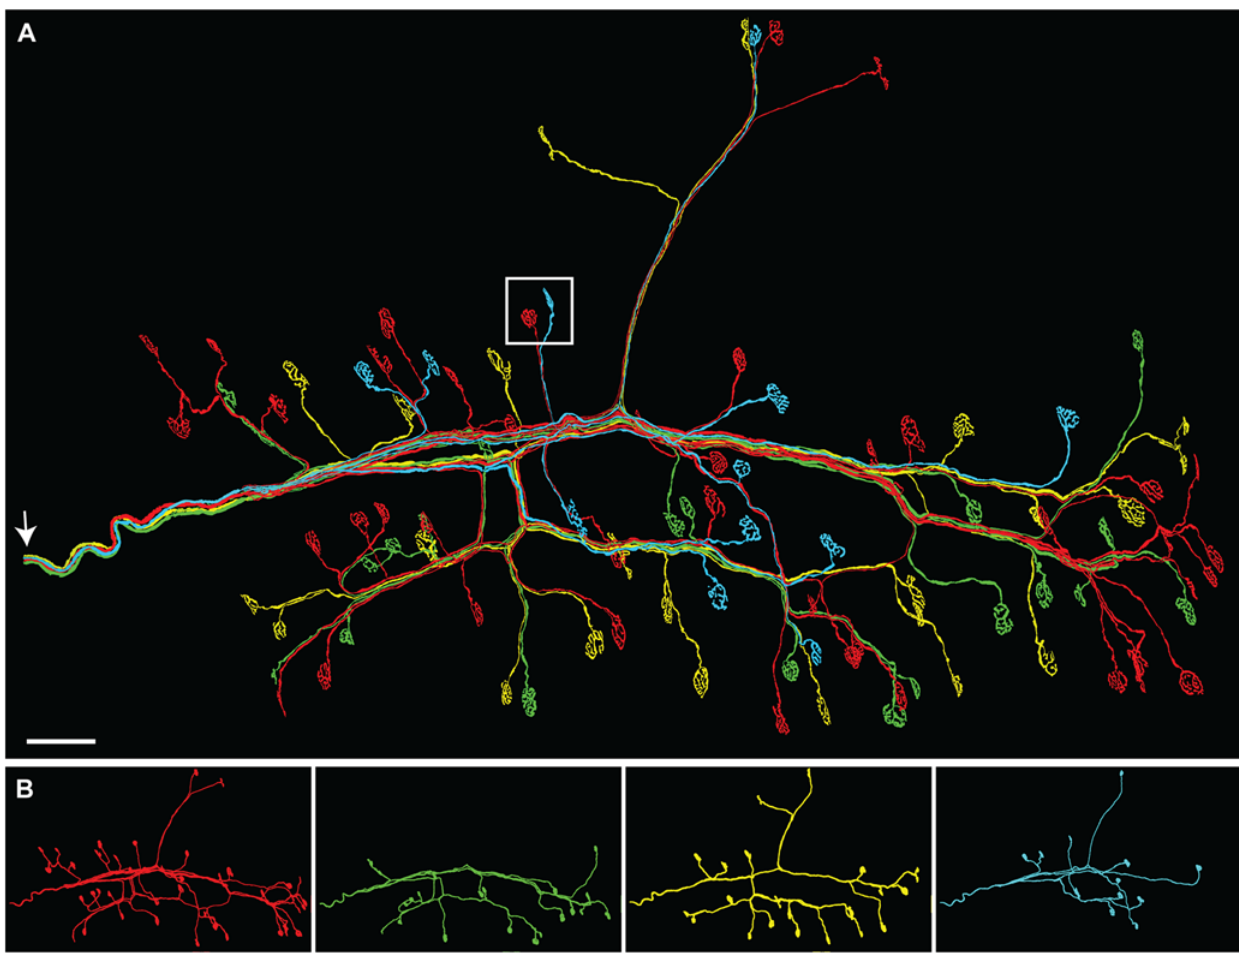
Figure 7. Full montage of reconstructed axons. A . The entire connectome of an omohyoid muscle with 4 axons and 96 neuromuscular junctions. The white square indicates the size of one single image stack relative to the full montage of 168 stacks. Arrow: the entry point of the nerve into the muscle. Scale bar: 100 m m. B . Each axon in the connectome shown separately. Motor unit size: red (41), green (22), yellow (21), cyan (12).